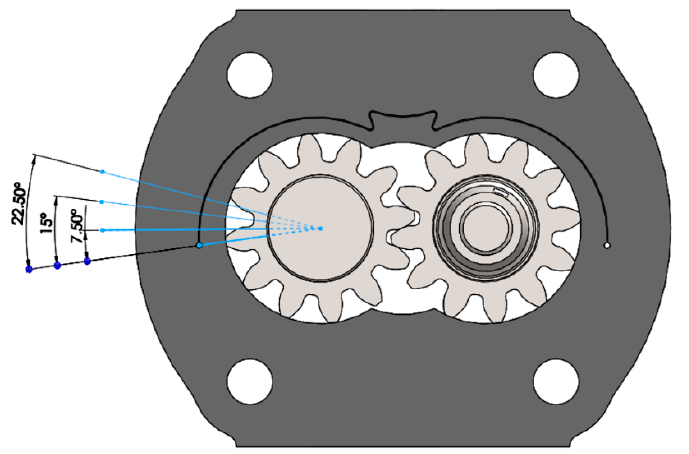
Figure 7. Geometric model of casing D with straight teeth, with four indicated compensation lip support points included in the calculations.